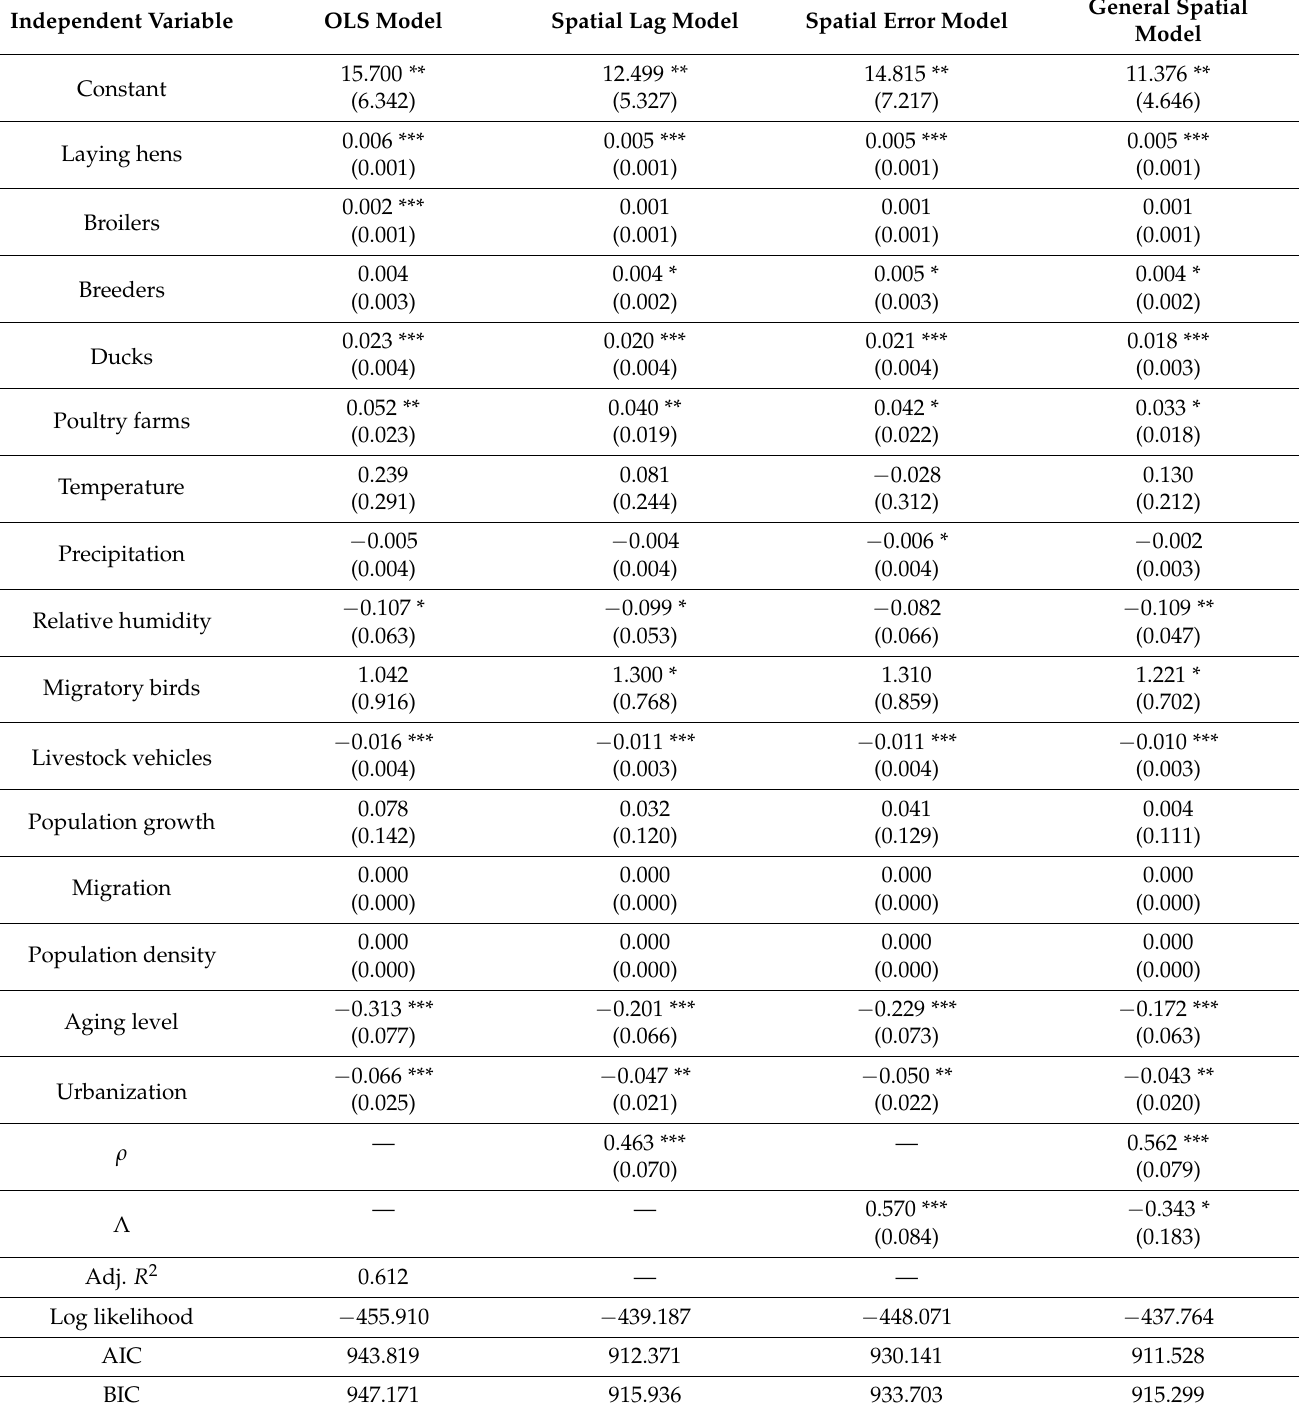
Table 3. Estimation results for highly pathogenic avian influenza (HPAI)